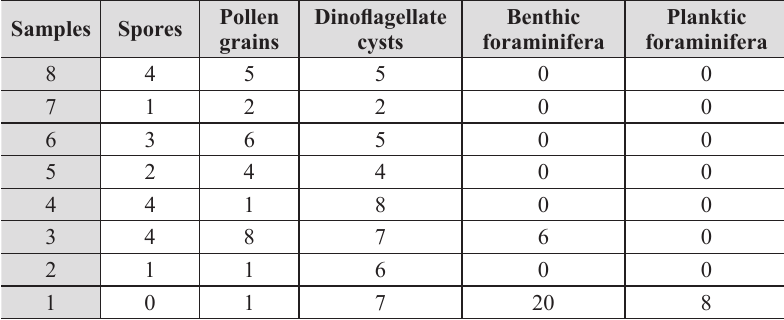
Abundance of genera of palynomorphs and foraminifera in the studied